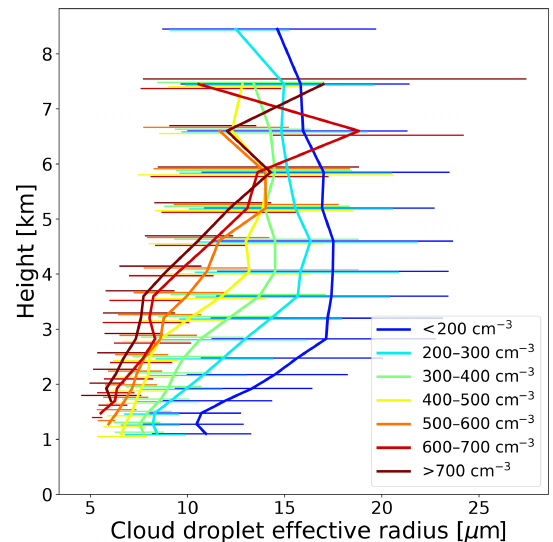
Figure 3. WRF-Chem-simulated median cloud droplet effective ra- dius vertical profiles from all nested-domain output during the study period, binned by below-cloud CCN concentration (cm − 3 at STP). Error bars represent the 20th to 80th percentile for each level and are offset vertically for